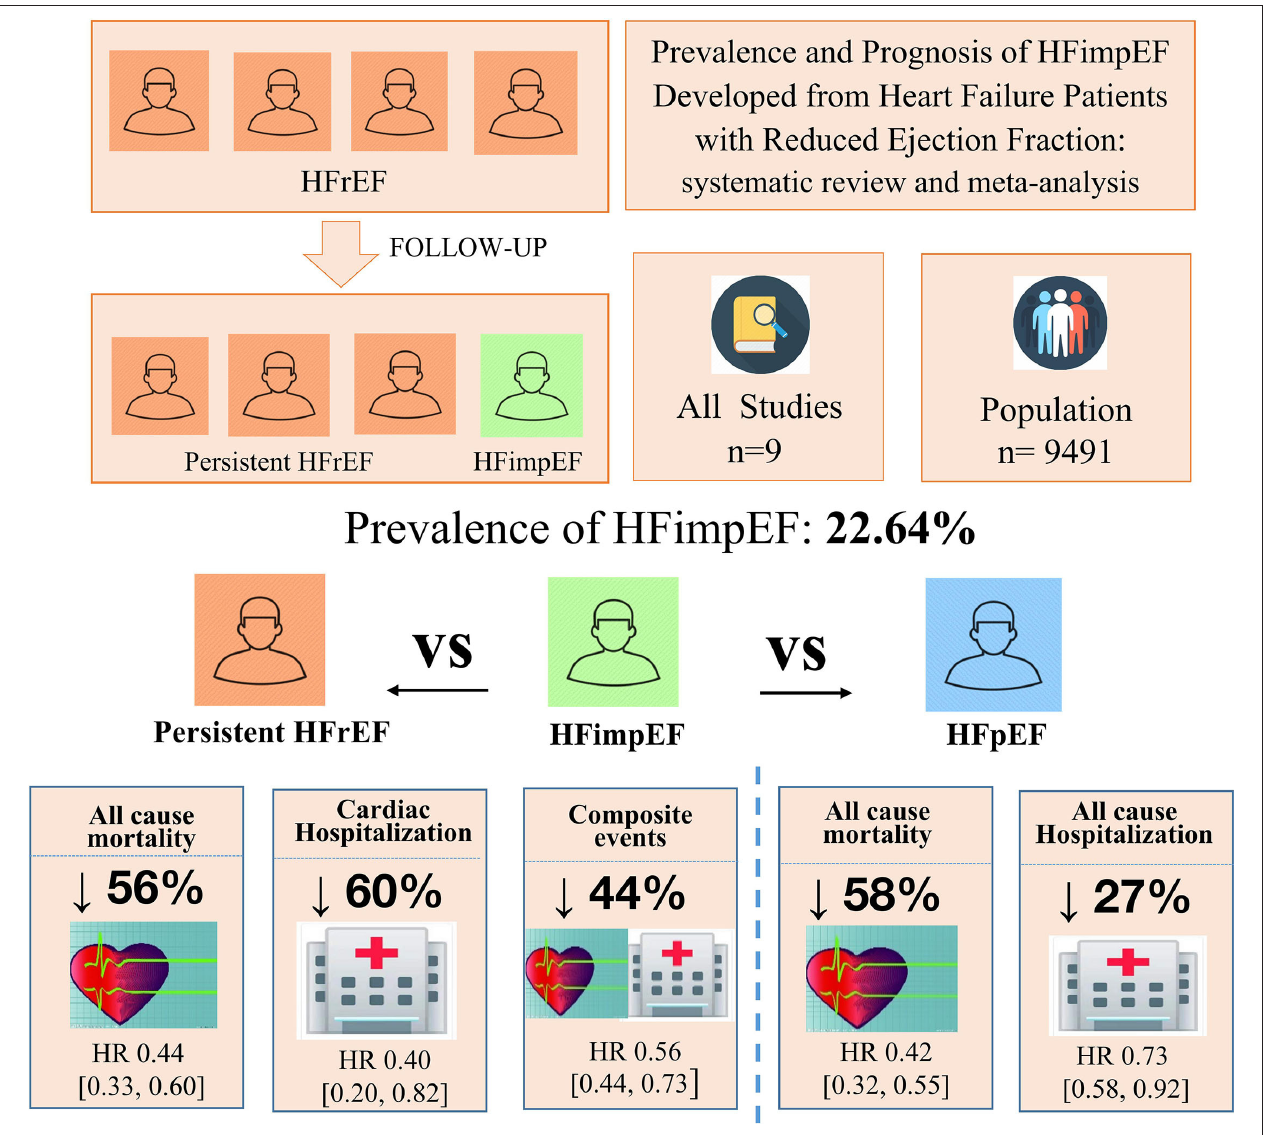
FIGURE 7 | Concluded chart of the study